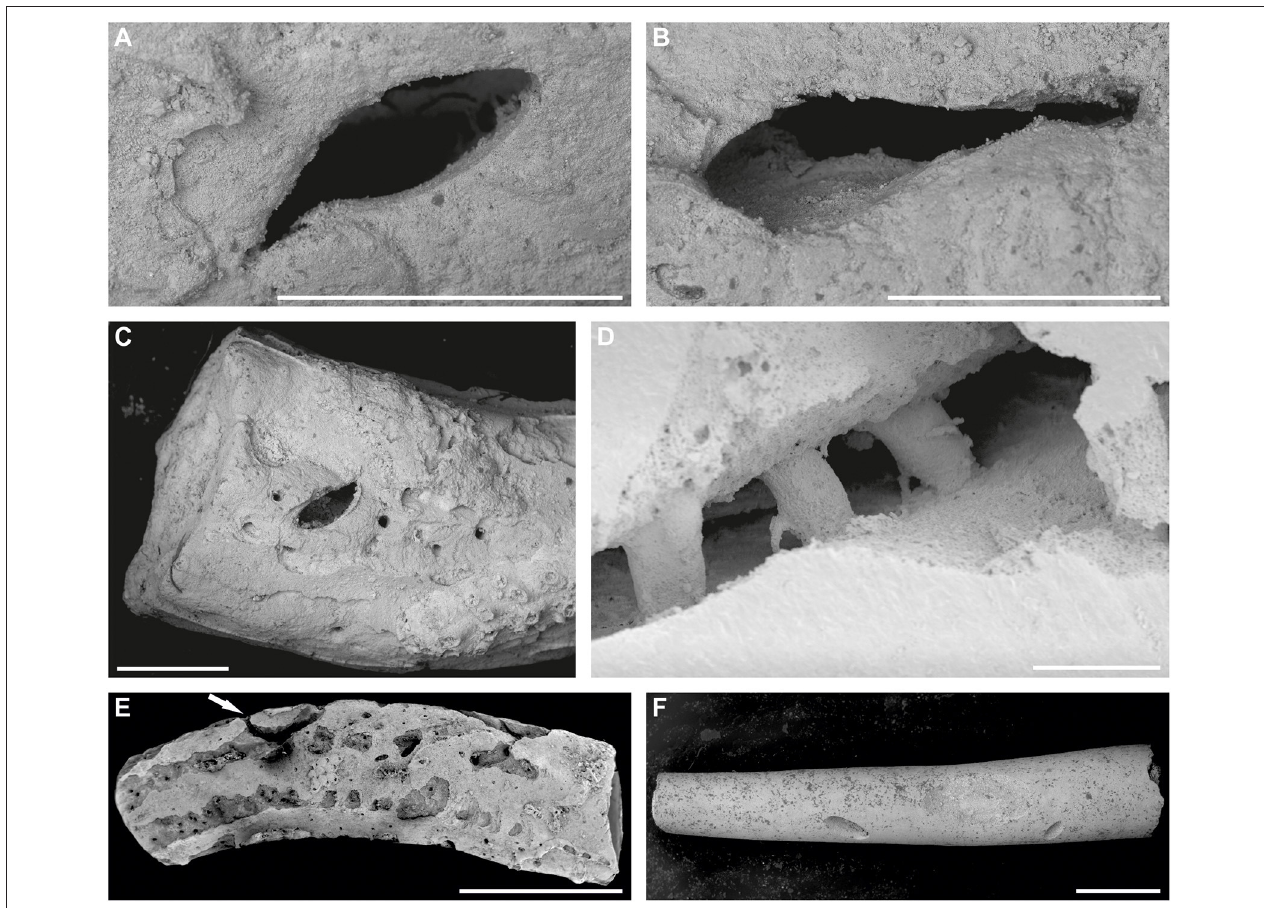
FIGURE 5 | (A–C) SEM images of Pyrgopolon ( P. ) deforme bored by Rogerella isp. showing in detail the most frequent shapes of ventricular outlets: (A,B) slit-like; MHNLM EMV 2015.3.13. (C) Almond-like; MHNLM EMV 2015.3.57. Specimens from Le Mans, France (cf. Ko ˇ cová Veselská et al., 2021, Figures 4A,B ). (D) Detail of the casted Cementula sp. with three robust shafts, two of them are slightly conical, and the third is barrel-shaped, interpreted as Iramena isp. The shafts are also connected to the surface of the substrate by arcuate tunnels. Specimen CZ2; Velim, Bohemian Cretaceous Basin, Czechia. (E) SEM image of Pyrgopolon ( P .) deforme with a variety of sclerobionts and borings; arrow points to Maeandropolydora isp.; MHNLM EMV 2016.3.9, Le Mans, France (cf. Ko ˇ cová Veselská et al., 2021 ). (F) SEM image of the inner tube of Pyrgopolon ( P. ) deforme , showing bottoms of roughly U-shaped borings, probably Rogerella isp.; MHNLM EMV 2015.3.83, Le Mans, France (cf. Ko ˇ cová Veselská et al., 2021). Scale bars = 1mm (A–C,E,F) , 200 µ m (D)